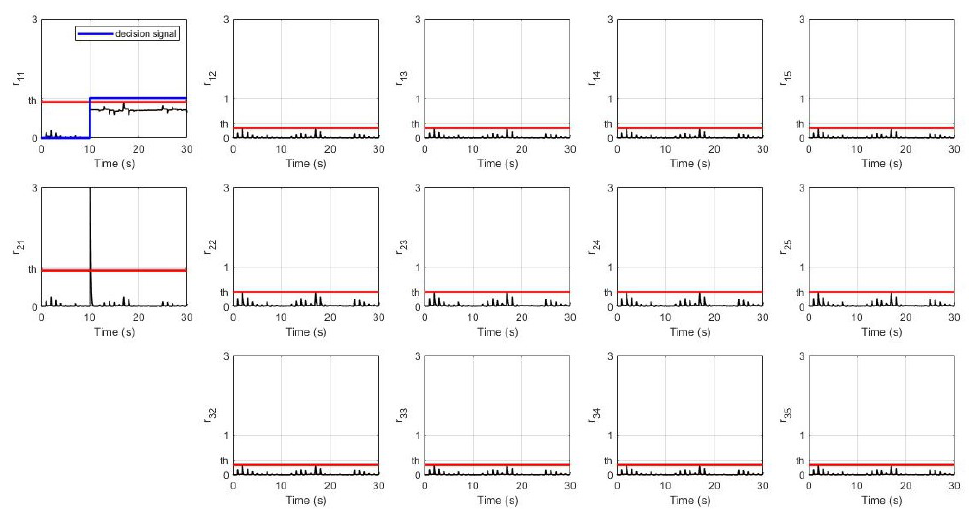
Figure 6. Residual signals with sensor S1 fault in the 1st